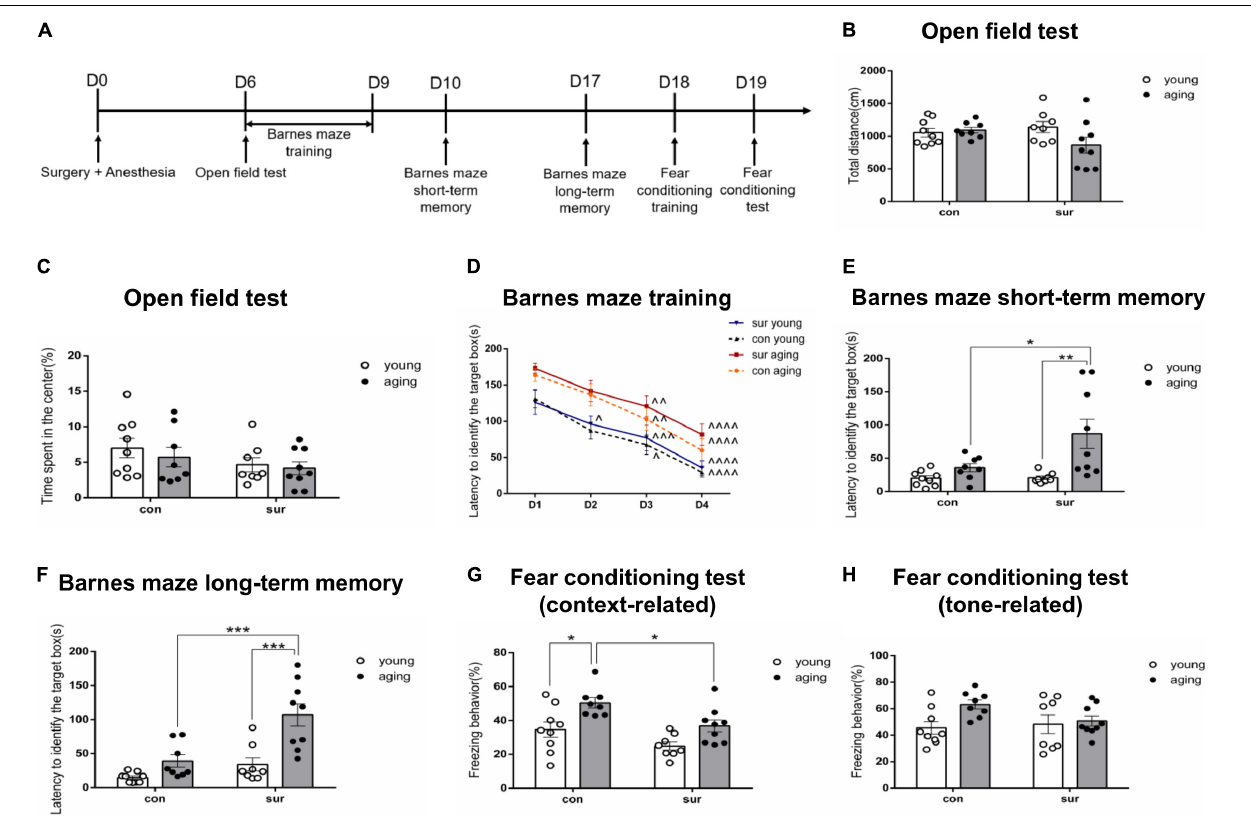
FIGURE 1 | Anesthesia/surgery caused age-dependent memory impairments in mice. (A) Timeline for behavioral tests. (B,C) Total distance moved and time spent in the center were recorded during the open field test. (D–F) Latency to identify the target box was recorded in the Barnes maze. (D) Barnes maze training sessions. (E) Barnes maze short-term memory test. (F) Barnes maze long-term memory test. (G,H) The time of contextual and tone freezing behavior was recorded during the fear conditioning test. ∧ p < 0.05, ∧∧ p < 0.01, ∧∧∧ p < 0.001, ∧∧∧∧ p < 0.0001 compared with the corresponding data on Day 1. * P < 0.05, ** P < 0.01 and *** P < 0.001 for pairwise comparisons. All data are presented as mean ± SEM ( n = 8 for young mice in the anesthesia/surgery group and aging mice in the control group. n = 9 for young mice in the control group and aging mice in the anesthesia/surgery